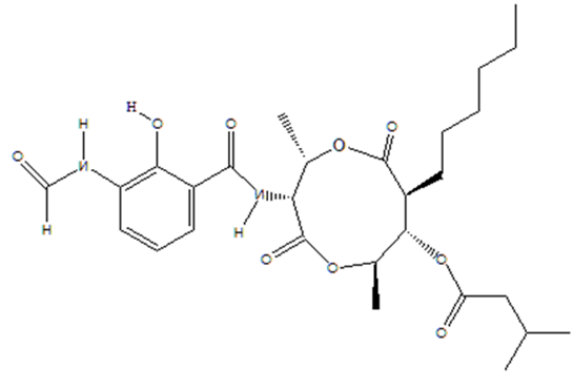
Figure 1. Structure of antimycin